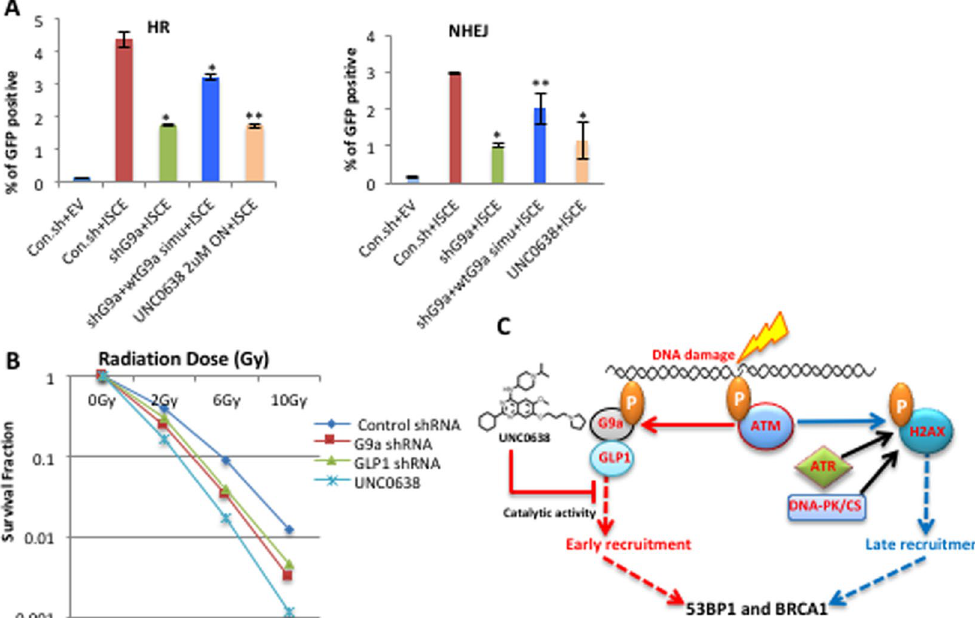
Figure 7. G9a promotes HR and non-homologous end-joining (NHEJ) repair. ( A ) Effects of G9a depletion with shRNA or catalytic inhibition of G9a with UNC0638 on GFP-based reporter assays of HR and NHEJ function are plotted. ( B ) Effects of G9a depletion or inhibition on cellular sensitivity to IR, as analyzed by colony formation in U20S cells. ( C ) A model for the relative roles of H2AX and G9a in early and late recruitment of 53BP1 and BRCA1. P, Phosphorylation. Data are expressed as the mean ± SEM of at least three experiments. ** P < 0.01, * P < 0.05. Scale bar 5 μ